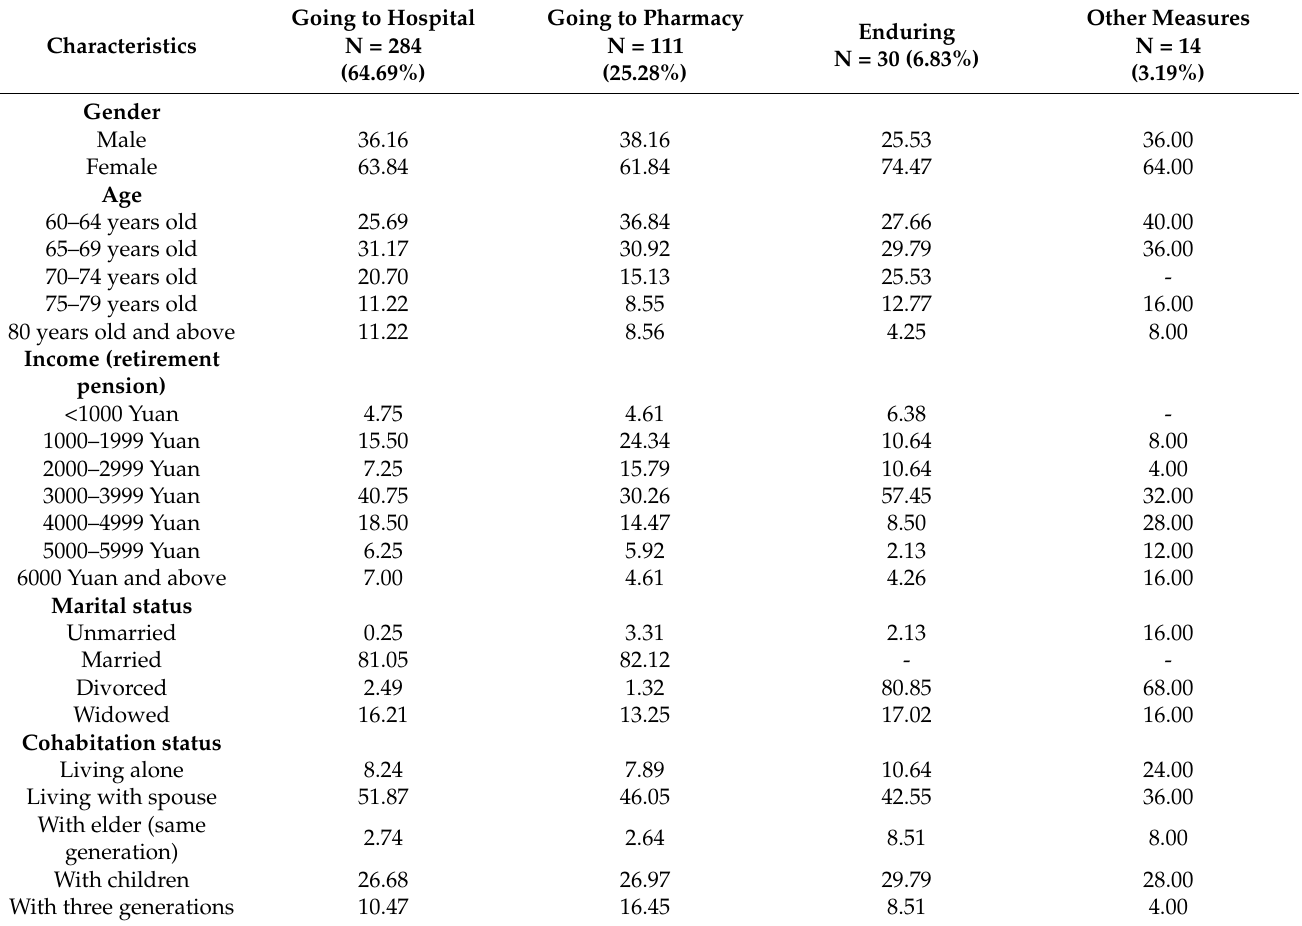
Table 1. The elderly population’s choices made in the condition of physical discomfort